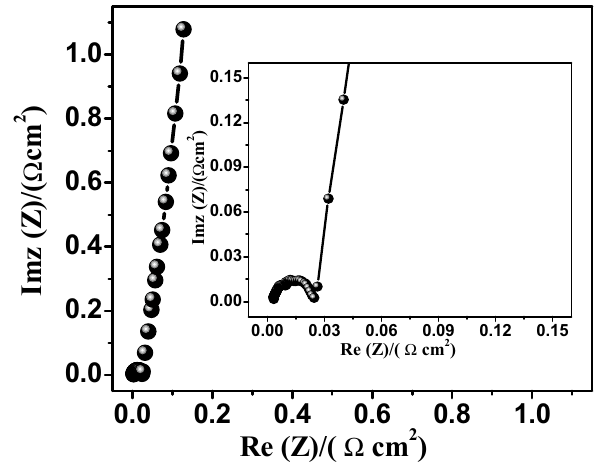
2 -RuO 2 mixed film, sample S3